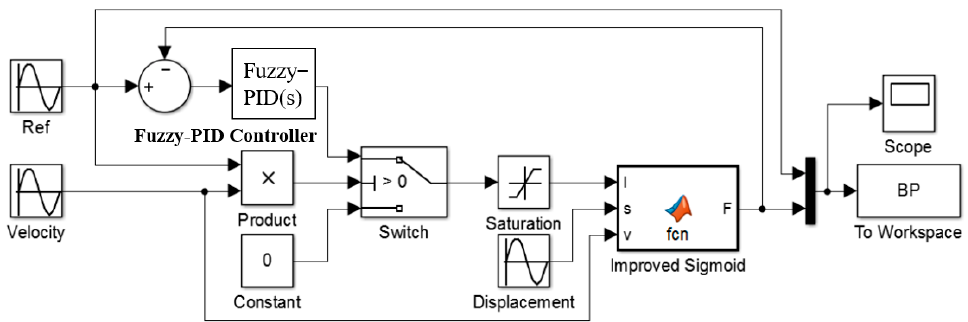
Figure 8. Simulink simulation model of parameter fuzzy–PID drive system.